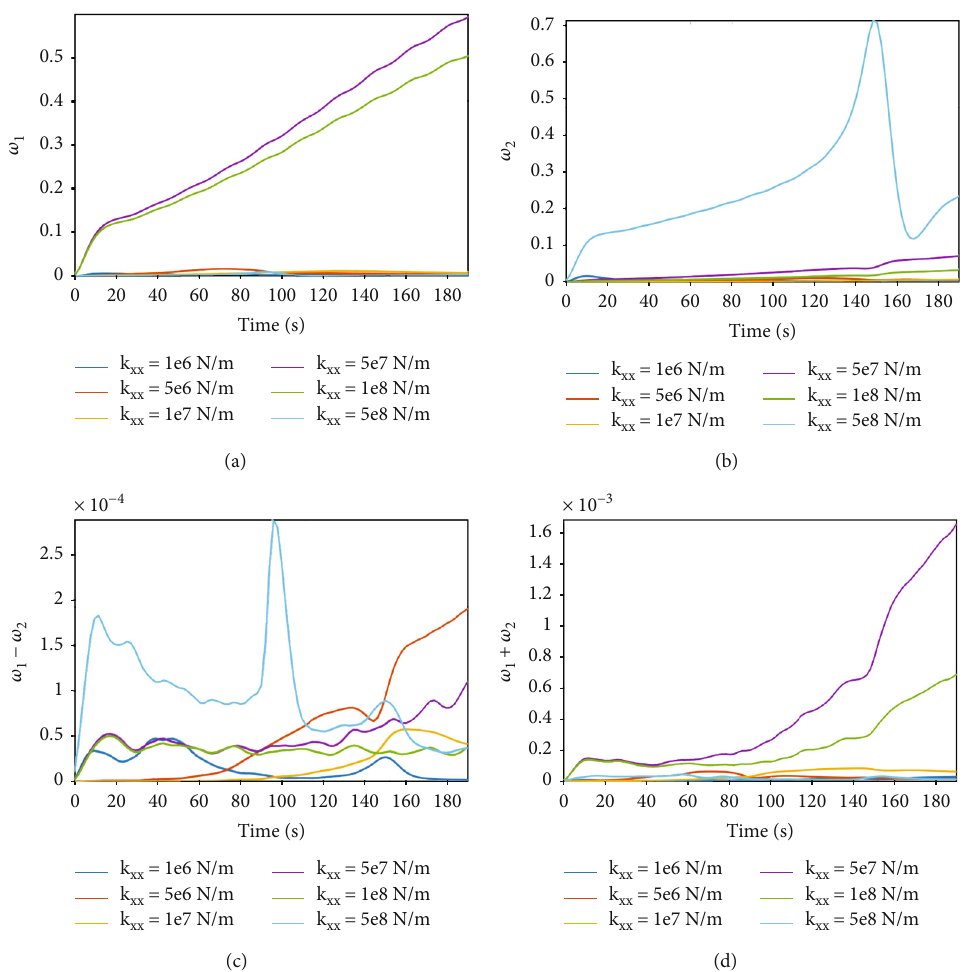
Figure 17: Responses at the analysis node of GG rotor with in fl uence of radial sti ff ness of SSS: (a) ω